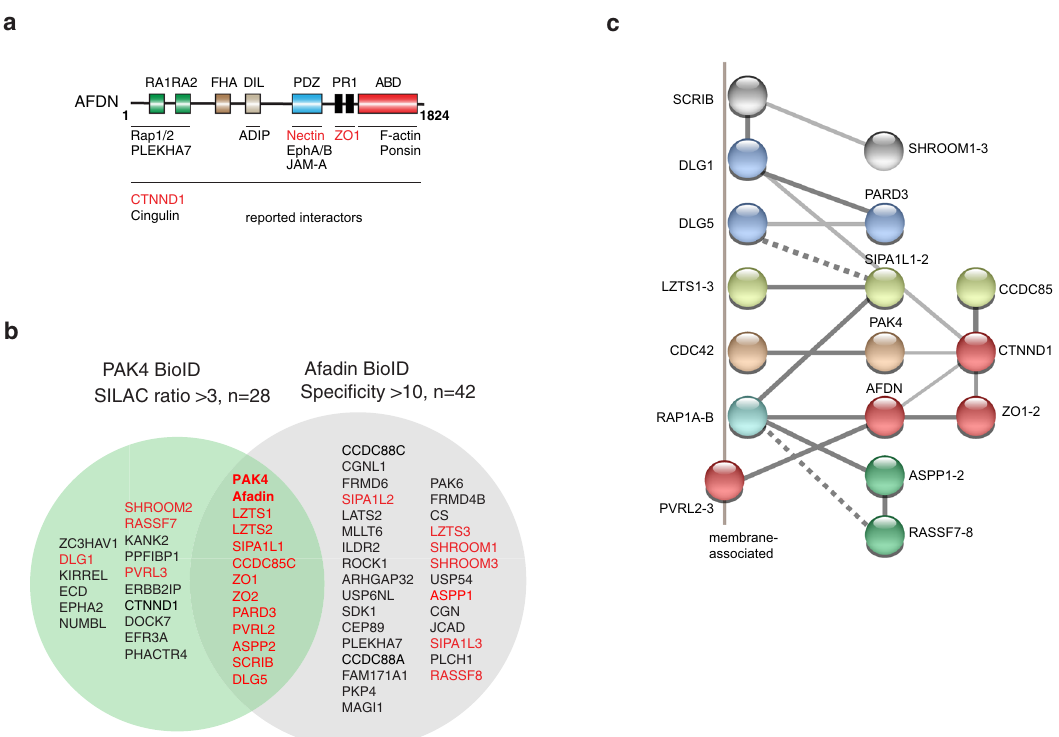
Fig. 2 Analyses of proximal proteins identi fi ed by PAK4 and Afadin BioID. a Schematic of Afadin domain structure and some previously identi fi ed interacting proteins, with those identi fi ed here labelled in red. b Diagram showing the extensive overlap between PAK4 (Table 1, SILAC with ratio >2.5) and Afadin proximal proteins (BioID data in Supplementary Data T1) which indicates these proteins share a similar junctional localization. Non-identical alternate isoforms of these shared proteins are also in red. c Proteins proximal to both PAK4 and Afadin are presented with putative sub-complexes (of different colours) based on validated (low throughput) protein – protein interaction data. To simplify the network different isoforms of the same proteins are shown as a single symbol, with the exception of DLG1 and DLG5. The proteins that are known to be membrane-bound (for example, by lipid anchors) or peripheral membrane proteins are placed in a juxta-membrane